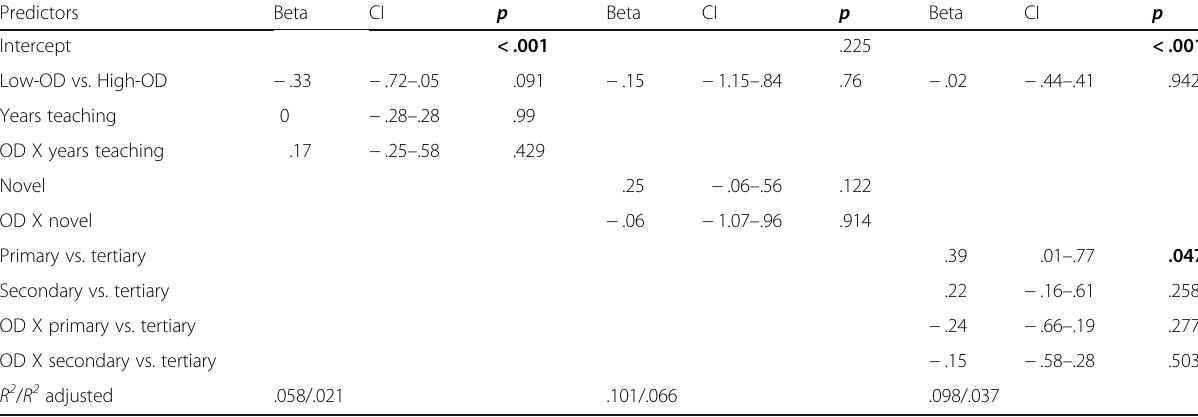
Table 3 Results of the exploratory regressions performed using teacher background variables from Experiment 6 with intention rating as the criterion variable